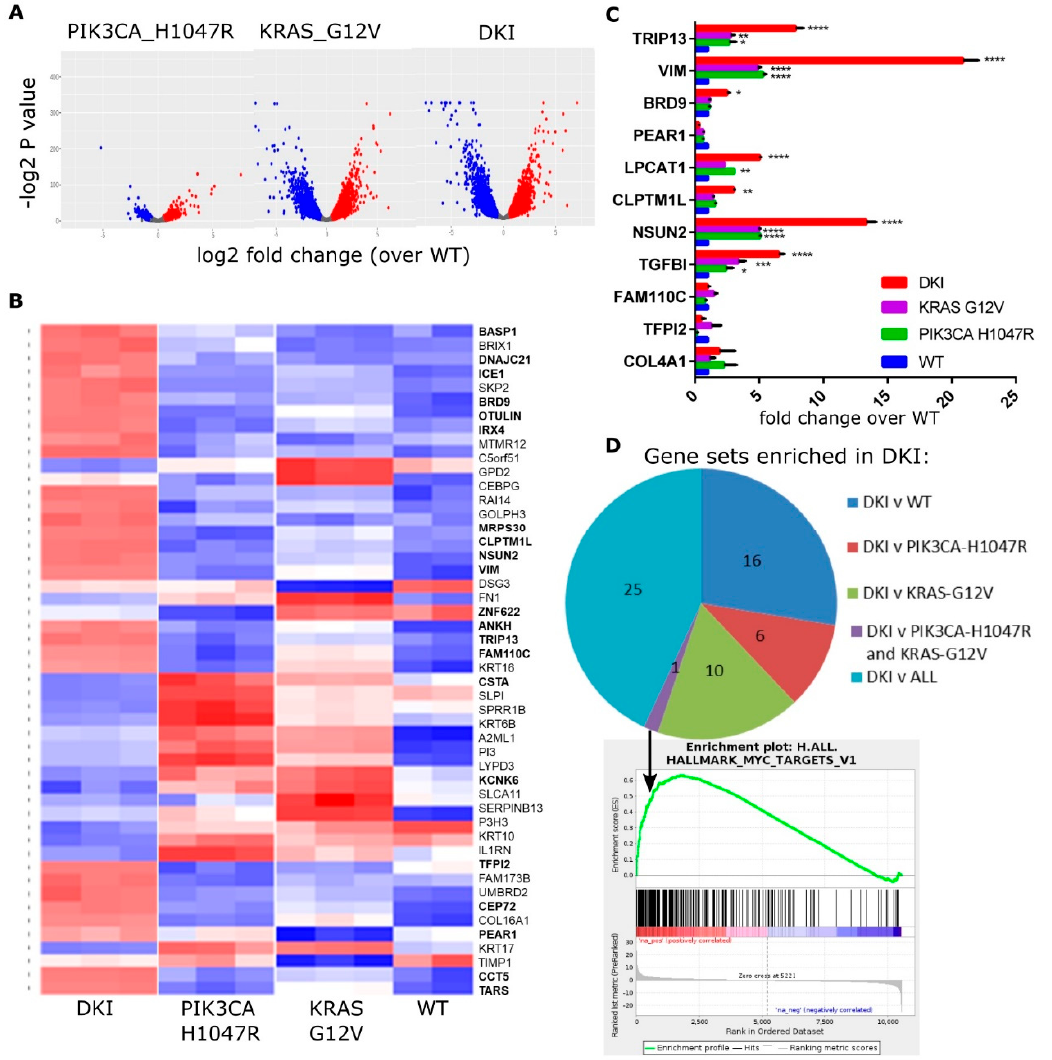
Figure 2. The KRAS and PIK3CA oncogenes cooperate to yield a MYC-target gene signature in DKI cells. ( A ) Volcano plots summarizing gene expression data, mutant vs. WT cells (log2FC vs. p value). ( B ) Heat map showing the top 50 upregulated (red) and downregulated (blue) genes in mutant cells compared to WT cells. Columns represent sequence reads from three separate RNA isolates per mutant cell line. ( C ) RT-qPCR data (Mean ± SEM, n = 3) showing mRNA levels of top DE genes in MCF-10A cells as identified by RNAseq. Data analyzed by 2-way ANOVA with Sidak’s multiple comparisons test (*, p < 0.05; **, p < 0.01; ***, p < 0.001). ( D ) Pie chart showing the number of Hallmark gene sets enriched in DKI cells as determined by GSEA of DKI vs. WT or single mutant cells. Bottom panel: Enrichment plot for gene set MYC_TARGETS_V1 generated using the rank ordered DE gene list of DKI vs. all